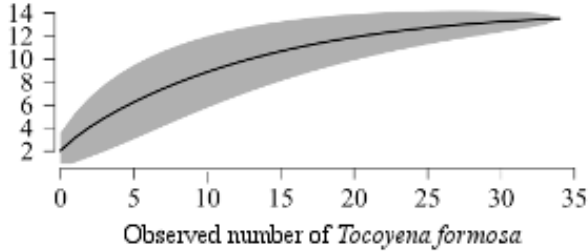
Fig 2 . A rarefaction curve with each individual of T. formosa as a sample in the x axis and the number of ant species in the y